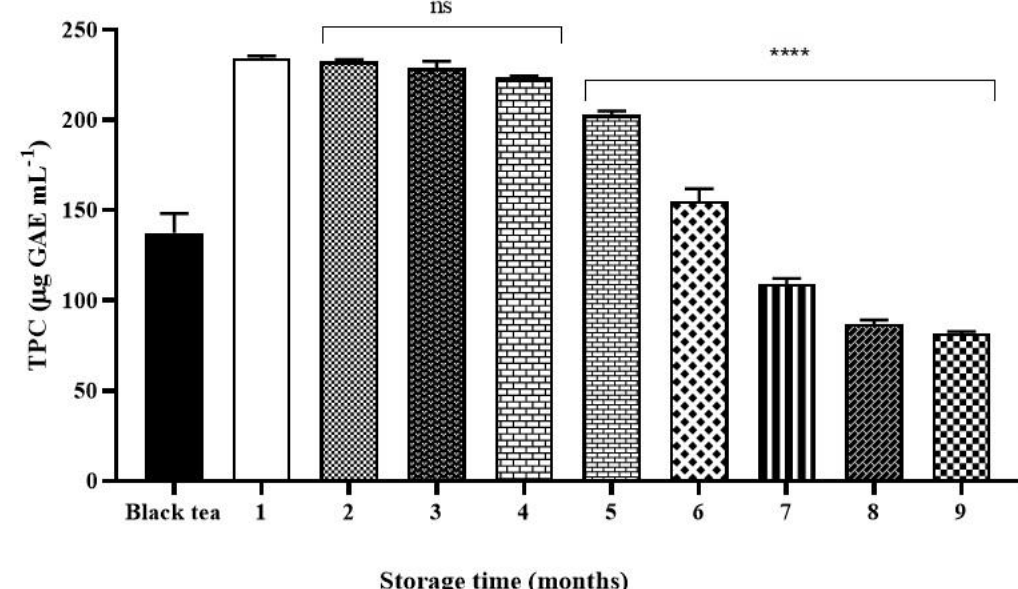
Figure 2. Total phenolic content (TPC) ( µ g GAE mL − 1 ) of black tea, kombucha tea after 30 days of fermentation and all the samples during storage. Black bar refers to the starting tea. White bar refers to the kombucha sample after 30 days of fermentation (control). Values represent the three-measure mean ± standard deviation. Asterisks on the bars indicate that mean values were statistically different from the white bar that represents the control (**** p < 0.0001).